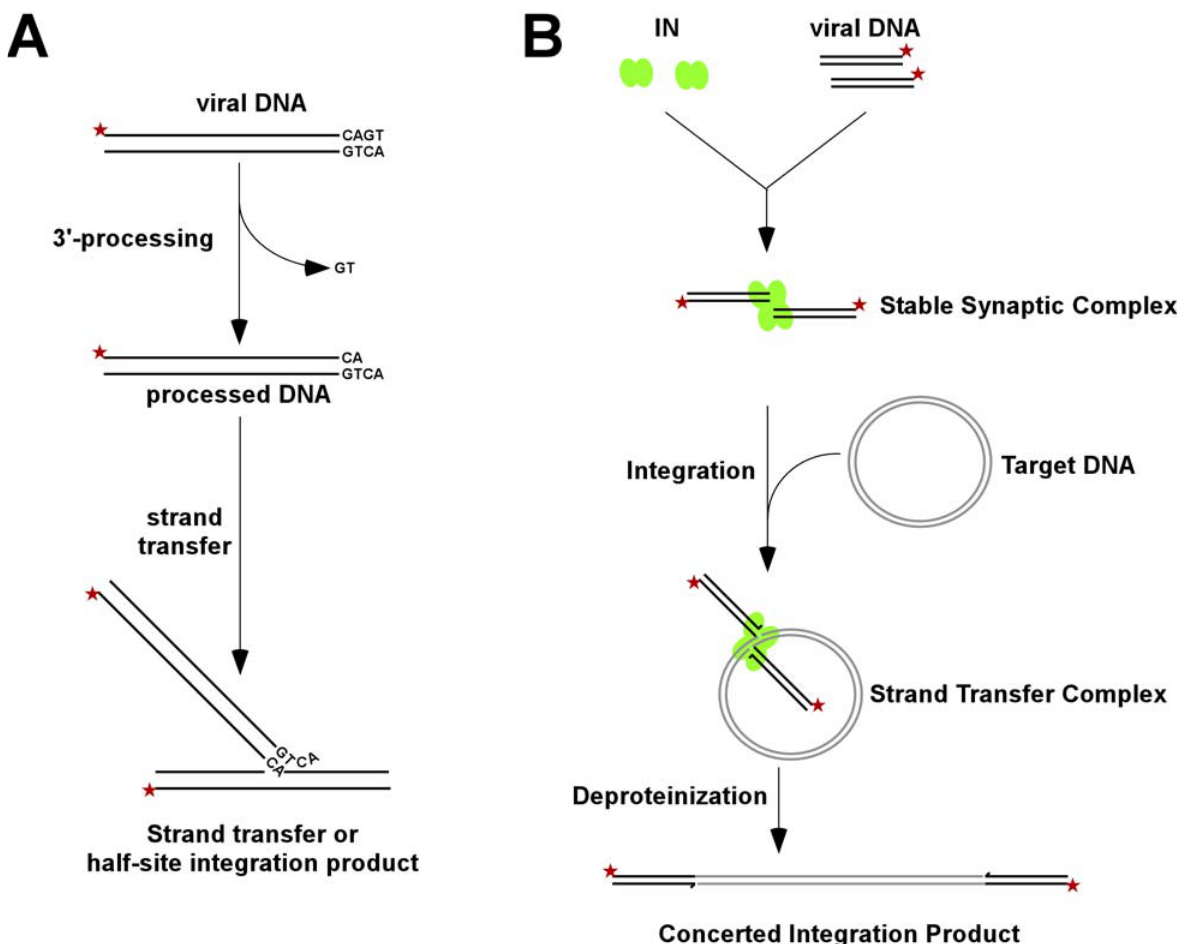
Figure 1. Schematic presentation of HIV-1 IN activity assays in vitro . (A) These reactions are typically performed with purified recombinant IN and 21-mer double-stranded DNA mimicking the U5 sequence. The enzyme first removes the GT dinucleotide from the 3’-terminal, and then covalently joins the recessed 3’-end to the target DNA. In these reactions the U5 sequence serves as both viral and target DNA. The strand transfer products result from integration of only one viral DNA end into the target DNA, while pair-wise integration products are not observed. (B) The concerted integration assays and critical nucleoprotein intermediates. Selective interaction of IN with viral DNA ends results in a highly stable nucleoprotein complex termed the stable synaptic complex (SSC). Next, IN in the context of SSC engages with the target DNA to form the strand transfer complex (STC), which carries out the concerted integration reaction. These nucleoprotein complexes are readily separated by native agarose gel electrophoresis. Deproteinization of the STC leads to the formation of the concerted integration product. The asterisks in A and B indicate the P 32 labeled 5’-end of viral